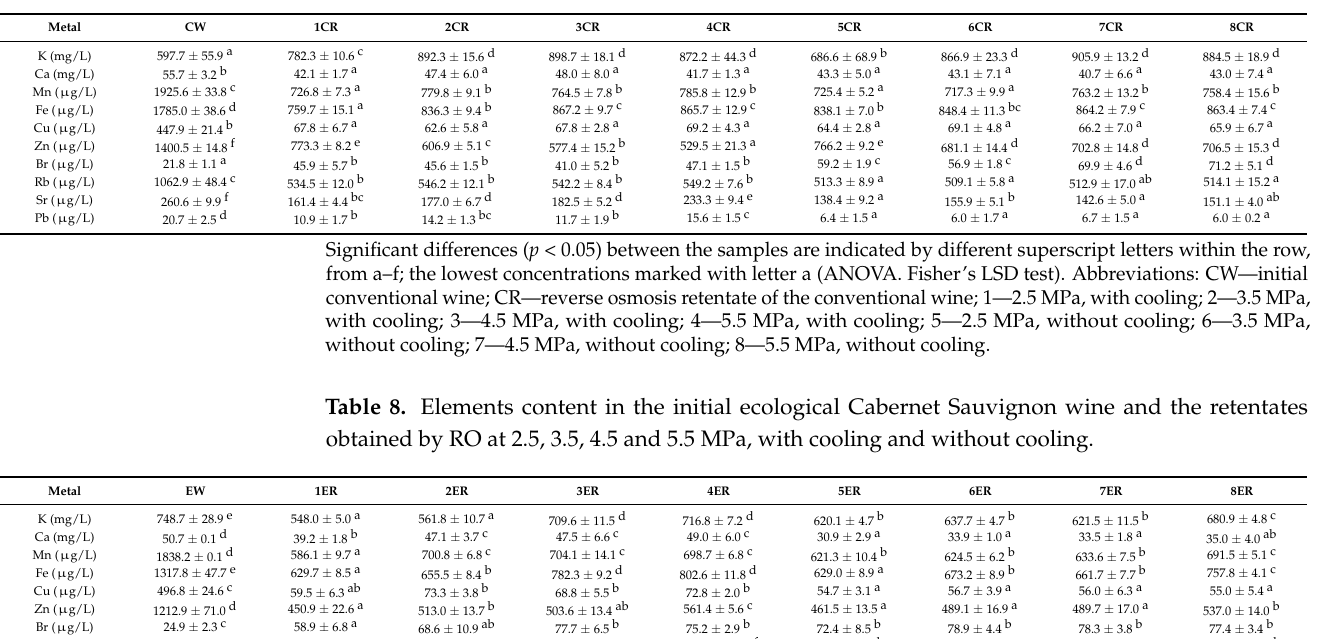
Table 7. Elements content in the initial conventional Cabernet Sauvignon wine and the retentates obtained by RO at 2.5, 3.5, 4.5 and 5.5 MPa, with cooling and without cooling.